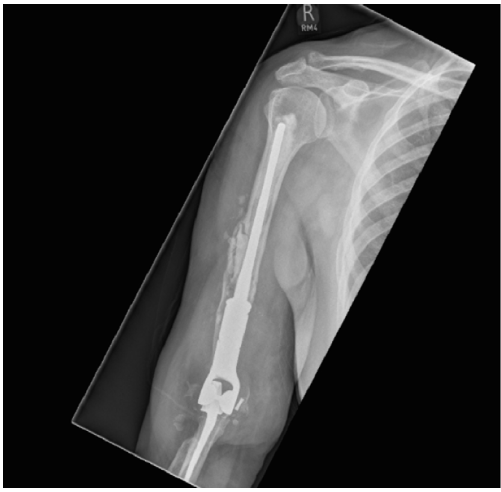
Figure 3. This figure shows the pre-operative radiograph for the third case, demonstrating an elbow replacement and a shoulder hemi-arthroplasty on the same side, with poor bone quality, loosening, and impending fracture.